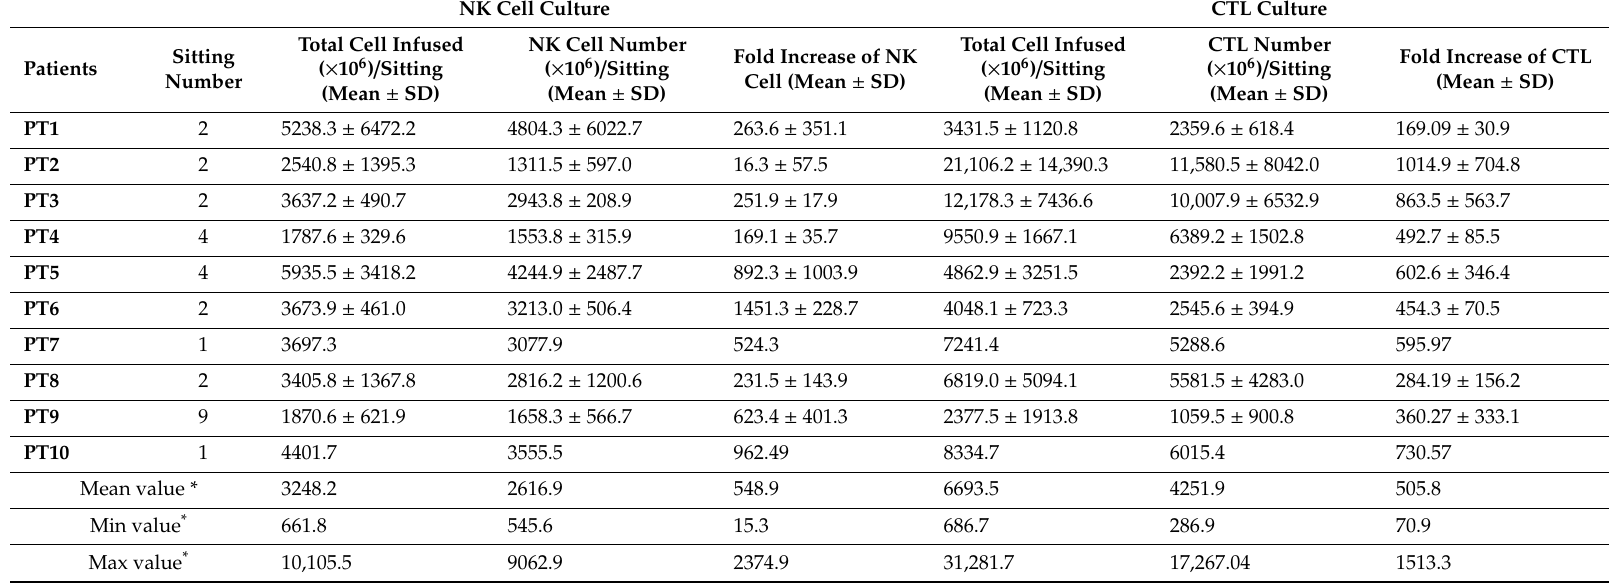
Table 2. Analysis of immune cells expansion, number of cell infusions, and cell